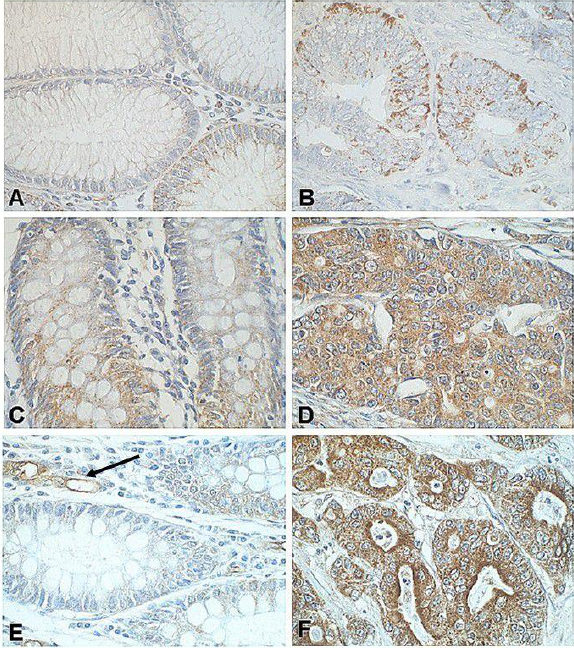
Figure 2. Representative images of the immunohistochemical detection of STT2, SST3 and SST5 as shown by brown staining of the crypt cells in normal colon mucosa and CRC cells forming glandular structures. ( A , C , E ) SST2-, SST3-, SST5-immunoreactive cells in normal colon mucosa, respectively; ( B ) Membranous pattern of IHC reaction for SST2 in CRC tissue sample. ( D , F ) Cytoplasmic SST3- and SST5 expression in CRC tissue samples, respectively. Worth noting is the positive IHC reaction for SST5 also on endothelial cells and/or vascular smooth muscle cells ( E ) (arrow). New polymer-based immunohistochemistry with DAB staining. Hematoxylin counterstained. Original magnification × 400 (own unpublished data).